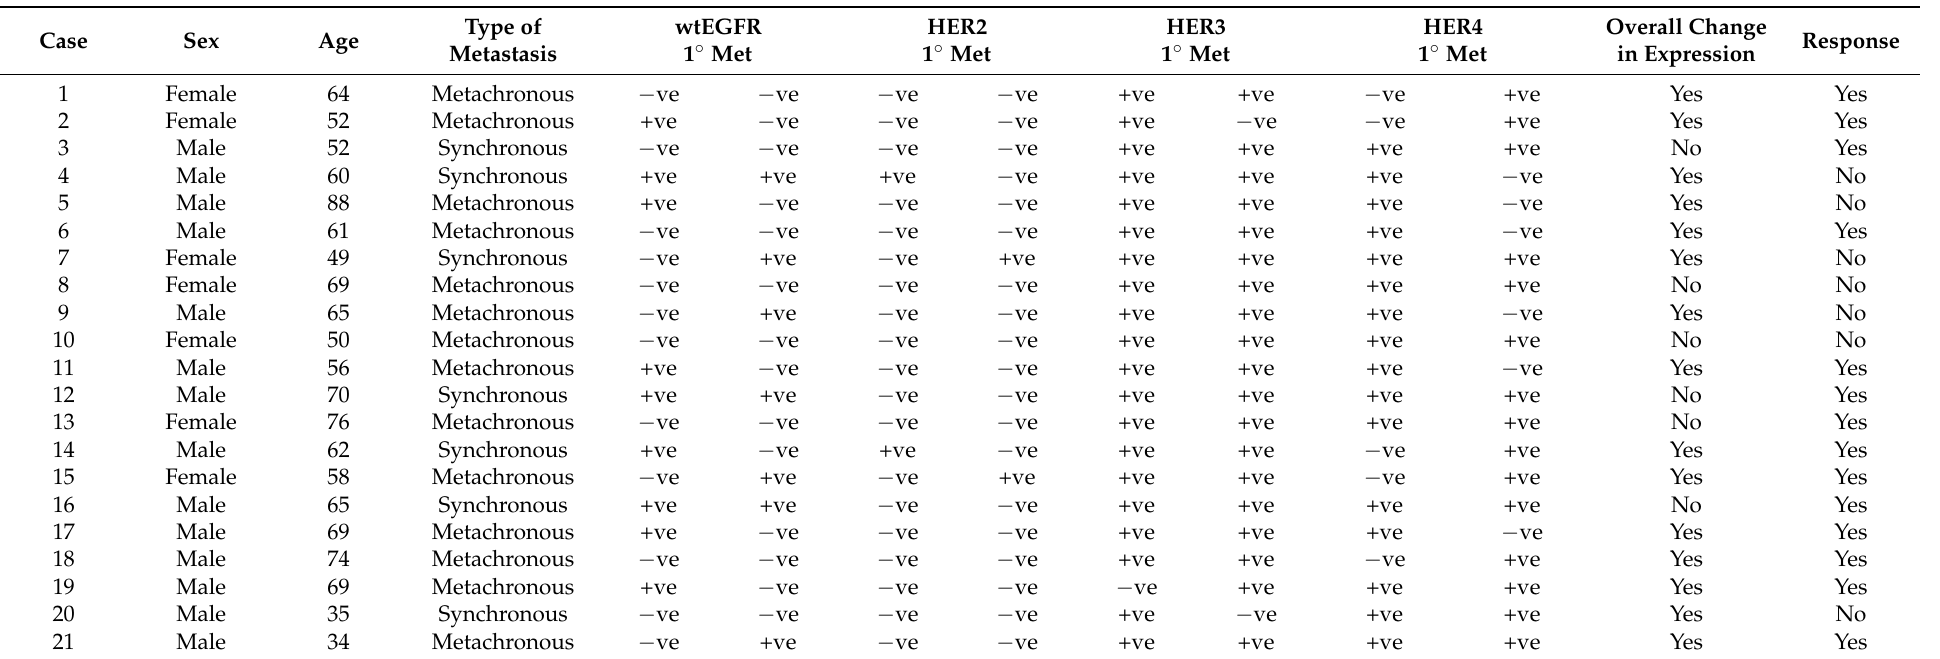
Table 3. Summary of HER expression in primary and corresponding metastatic lesions in CRC patients treated with anti-EGFR